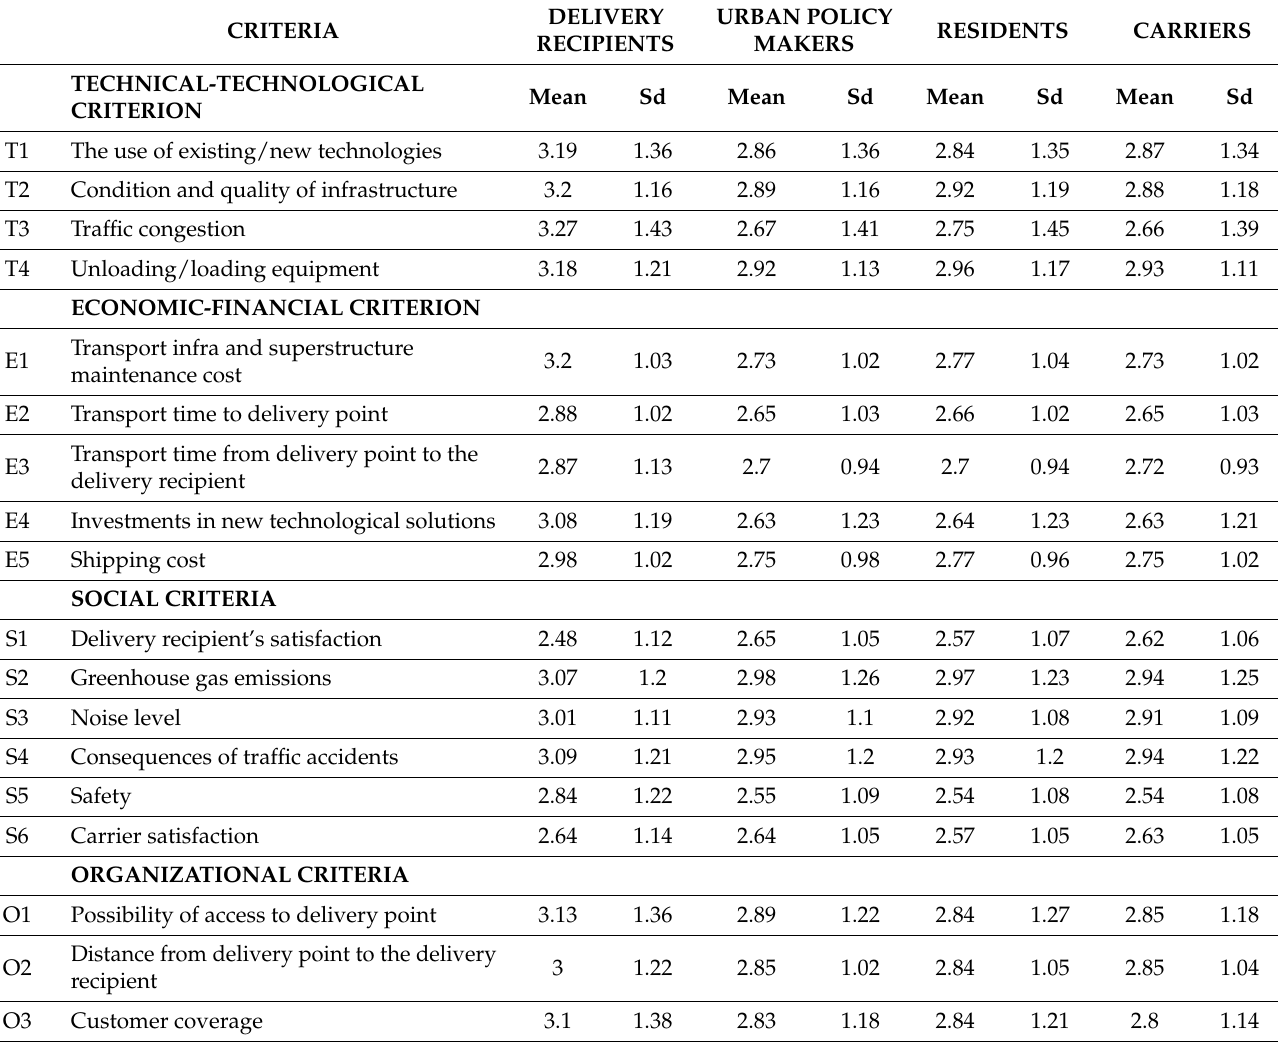
Table 1. Relevance of the criteria evaluated by all